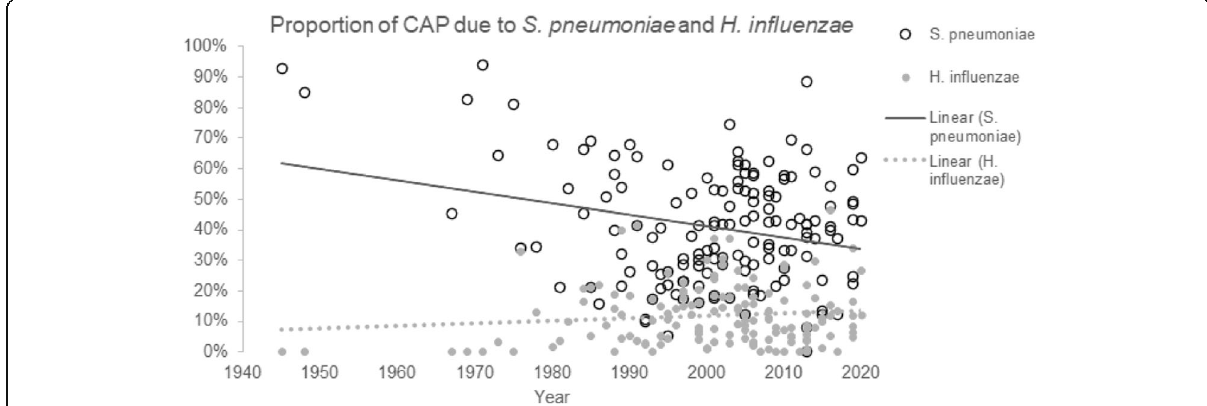
Fig. 2 Trends of identification of S. pneumoniae and H. influenzae as the etiology of CAP